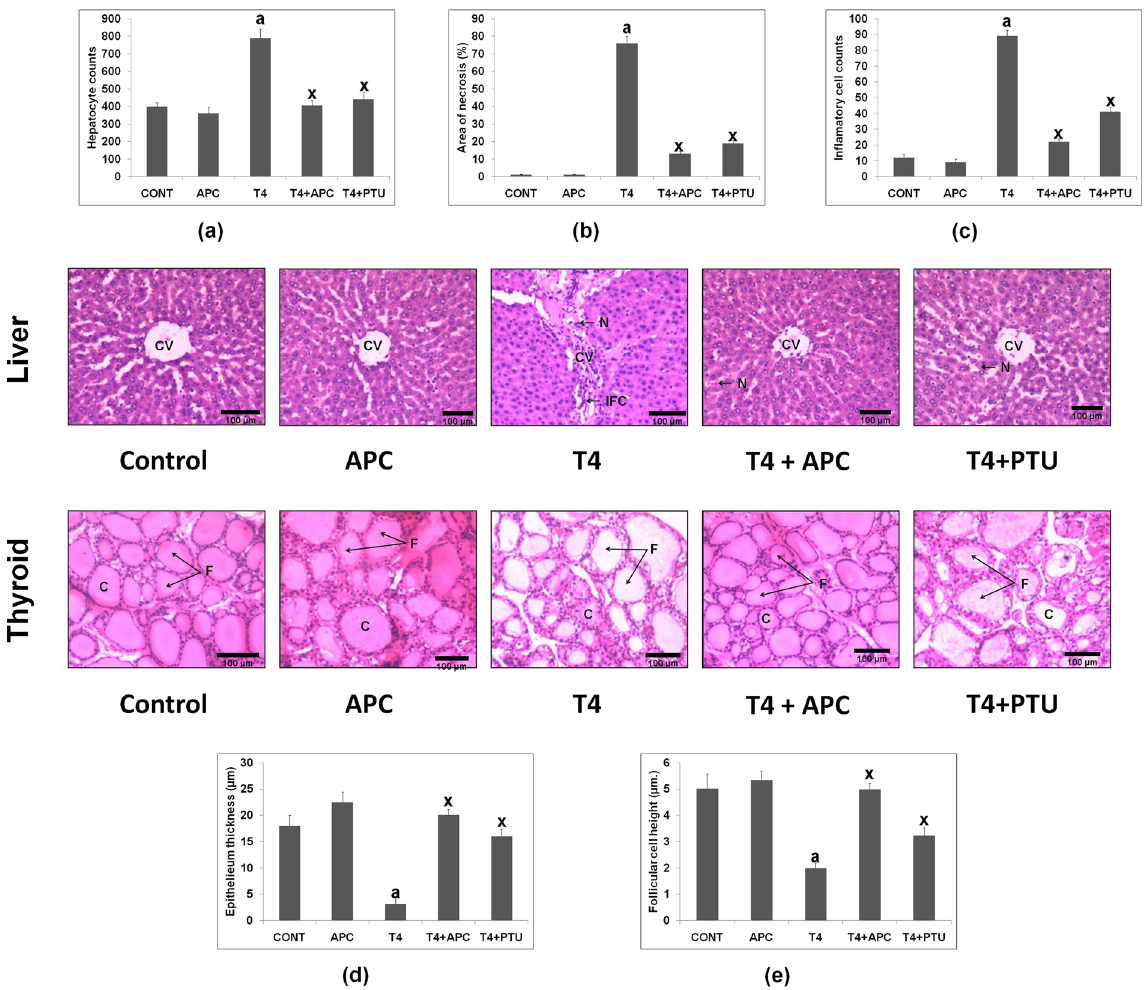
Figure 6. Effects of APC on the histological changes in liver and thyroid gland of T 4 treated rats [H and E stain (10x)]. Liver section of control group shows the central vein (CV) surrounded by the radiating cords of hepatocytes, whereas T 4 -induced rat liver shows inflammatory cell infiltrations and cellular damage. In liver section of APC treated animal, cords of normal hepatocytes (H) radiating from the central vein (CV) are seen. In T 4 -induced APC treated rat liver, near normal histological structure is seen with normal hepatocytes. Only moderate degree of liver damage is seen in the T 4 -induced animals that received PTU also. N = necrotic area, IFC = inflammatory cells (arrows). ( a ) In T 4 -induced thyrotoxic liver, an increase in the hepatocytes number was found, but in T 4 + APC and T 4 + PTU groups, there was a reduction in the number of hepatocytes as compared to that of thyrotoxic liver. Data are presented as mean ± SEM (n = 5 per each group). a P < 0.001 as compared to the respective control value. x P < 0.001 as compared to the respective value of the T 4 -induced animals. ( b ) Quantitative analysis of liver necrosis. In T 4 - treated rats the percent necrotic area was increased as compared to that of control rats (n = 5). This was determined by random evaluation of each HE-stained section. However, in T 4 + APC and T 4 + PTU groups, decreased area of necrosis (%) was observed as compared to that of thyrotoxic liver. Data are presented as mean ± SEM. (n = 5 in each group). a P < 0.001 as compared to the respective control value. x P < 0.001 as compared to the respective value of the T 4 - induced animals. ( c ) Histological changes also indicate increased inflammatory cell count in T 4 -induced thyrotoxic liver which is reduced in T 4 + APC and T 4 + PTU treated animals, as compared to the thyrotoxic liver. Data are presented as mean ± SEM. (n = 5 in each group). a P < 0.001 as compared to the respective control value. x P < 0.001 as compared to the respective value of the T 4 - induced animals. Representative photomicrographs of thyroid tissues in H&E-stained images (10x) showing marked changes in thyroid section of APC or T 4 + APC or PTU treated rats. In control rats normal thyroid follicles (F) lined with a single layer of cuboidal follicular cells are seen, while in T 4 –induced rats, thyroid follicles are markedly distended with less amount of colloid. The thyroid sections of animals treated with T 4 + APC or T 4 + PTU show marked improvement in the thyroid follicles. In only APC treated animal, no alteration in the histological structure of thyroid follicles is seen exhibiting nearly normal histological features. F = follicle; C = colloid. ( d ) Changes in the follicular lining epithelium thickness (measured as morphological assessment) of the thyroid gland are seen following APC treatment. While epithelium thickness was reduced in T 4 -induced thyrotoxic rats, thyroid section of T 4 + APC and T 4 + PTU showed almost normal follicular lining epithelium. Data are presented as mean ± SEM (n = 5 per